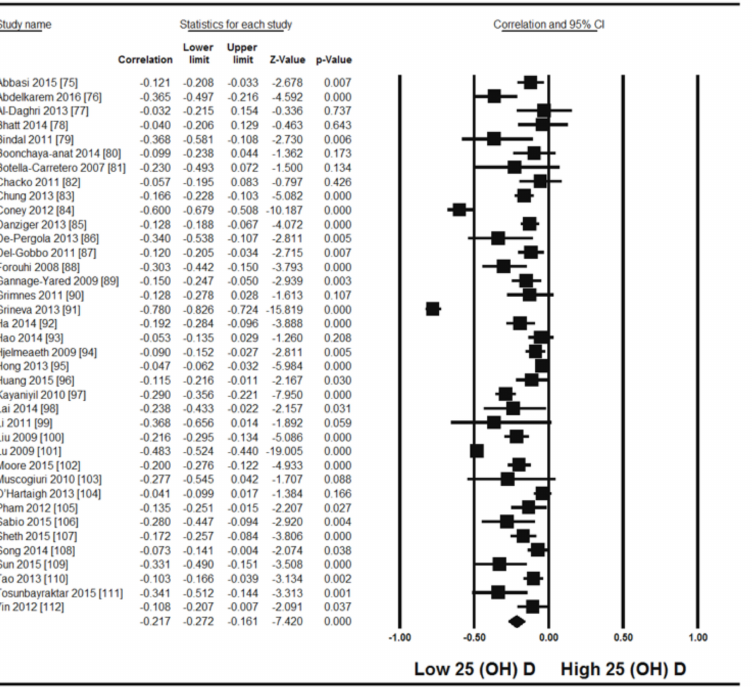
Figure 2. Forest plot showing the relationship of vitamin D status and HOMAIR [75–112], 95% confidence interval (CI) (I 2 = 94.4% p = 0.00) and correlation were calculated by using random effect